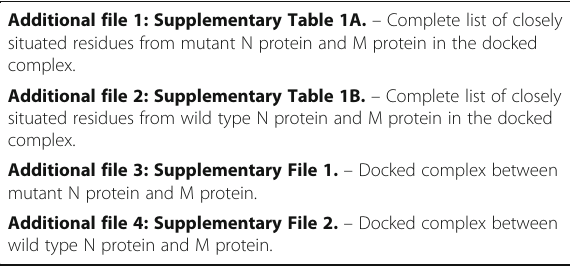
Additional file 4: Supplementary File 2. – Docked complex between wild type N protein and M protein.